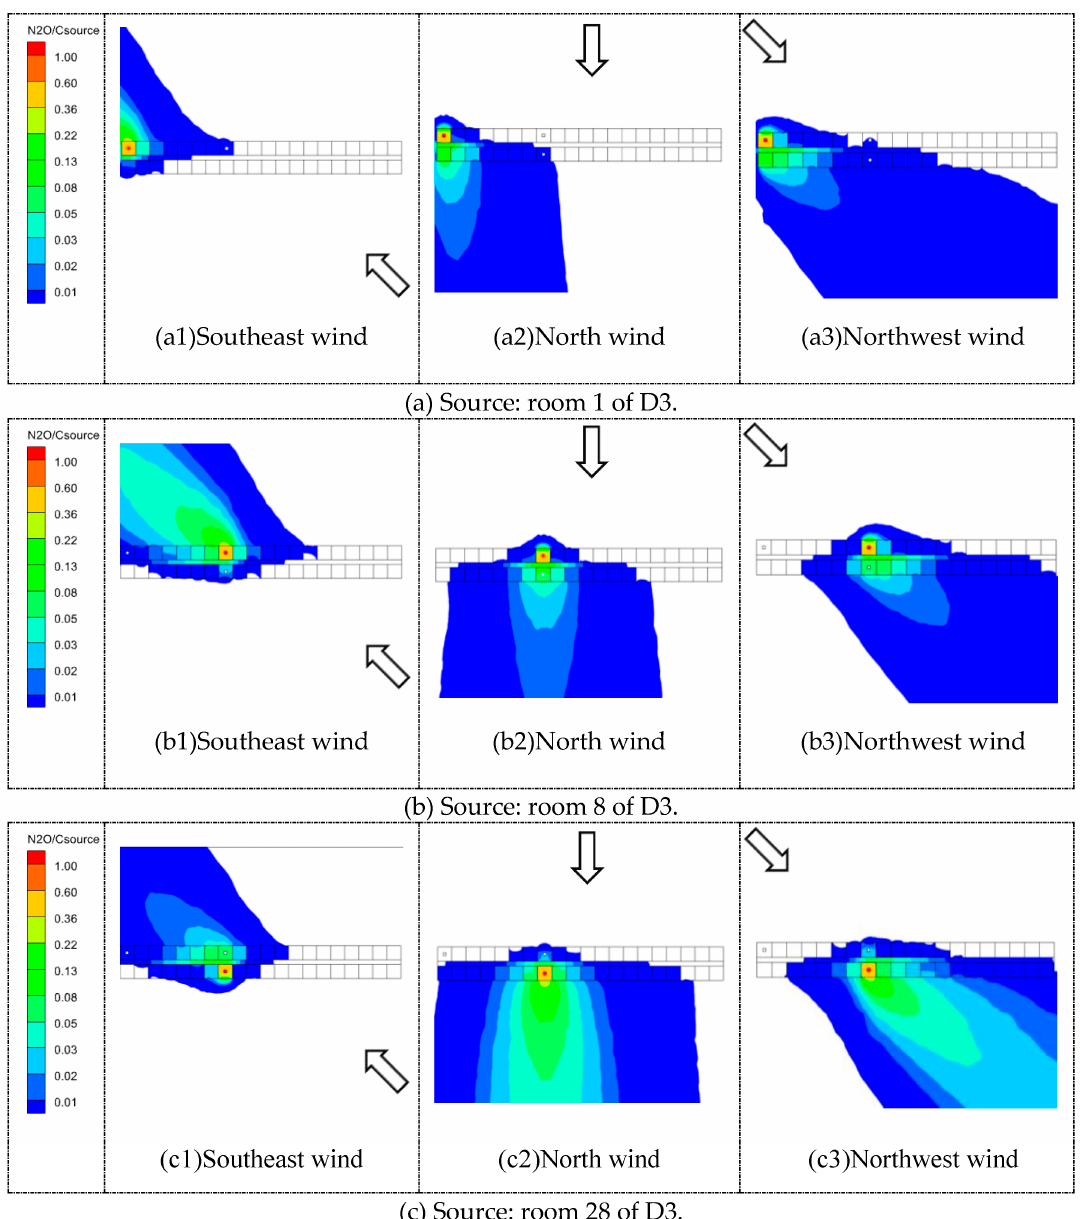
Figure 18. Comparisons of nondimensional concentration fields on horizontal plane Z = 0.76 m with diverse source locations under three wind directions. Arrows represent three different wind direc- tions.